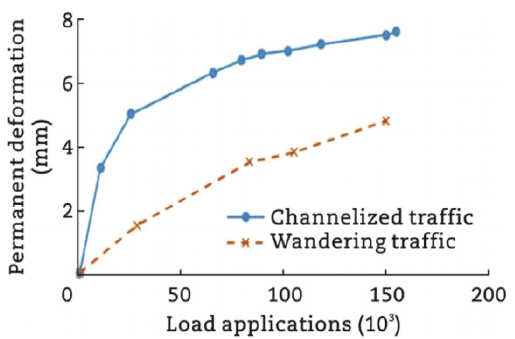
Figure 10. Channelized versus wandering permanent deformation response [46].